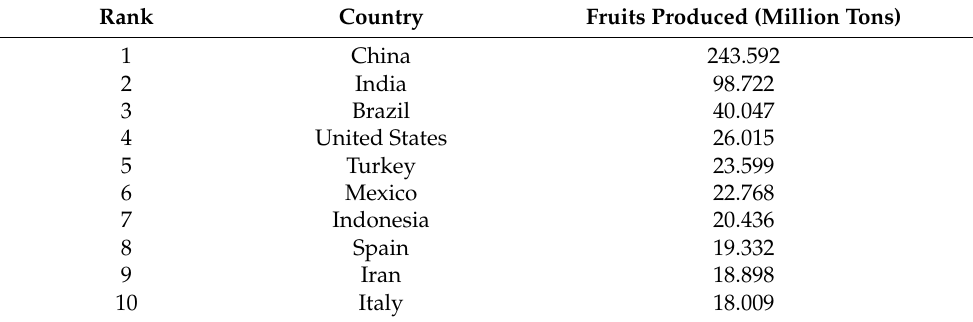
Table 1. Top fruit producing countries in the world in 2018 [7]. Rank Country Fruits Produced (Million Tons) 1